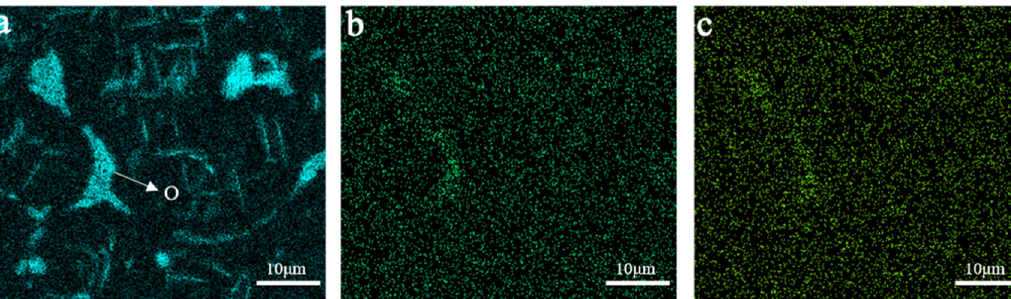
Figure 7. Elemental mapping of the alloy homogenized at 515 °C for 20 h: ( a ) Cu (Cu-rich precipitates arrowed by O), ( b ) Ce, and ( c ) La elements. Table 2. Chemical composition of marked phases in homogenized alloys.